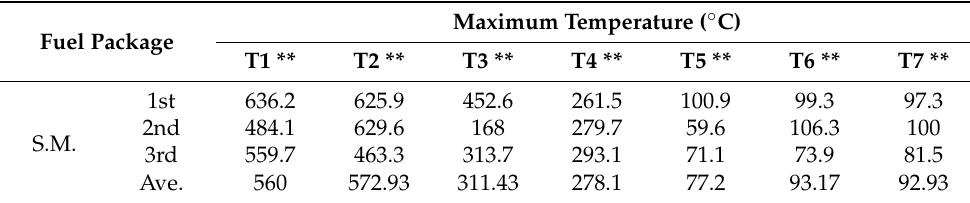
Table 4. Maximum temperatures by thermocouple position in the fire tests at a discharge pressure of 0.7 bars (0.07